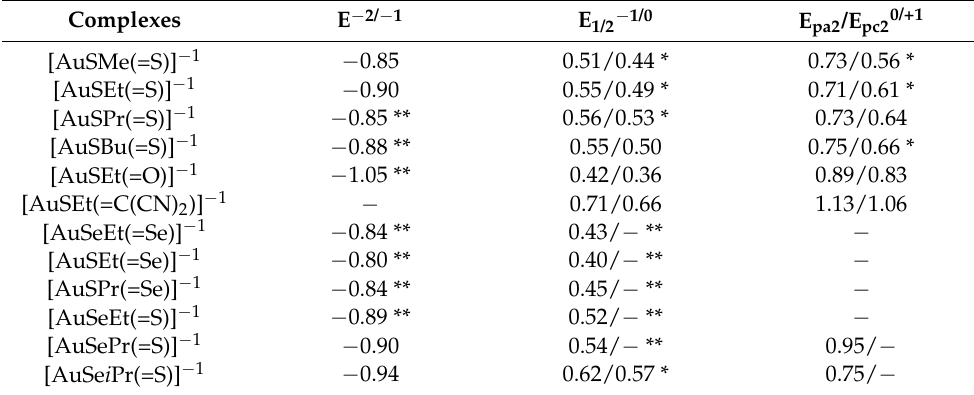
Table 1. Redox potentials of gold bis(dithiolene) and bis(diselenolene) complexes (E in V vs. SCE)